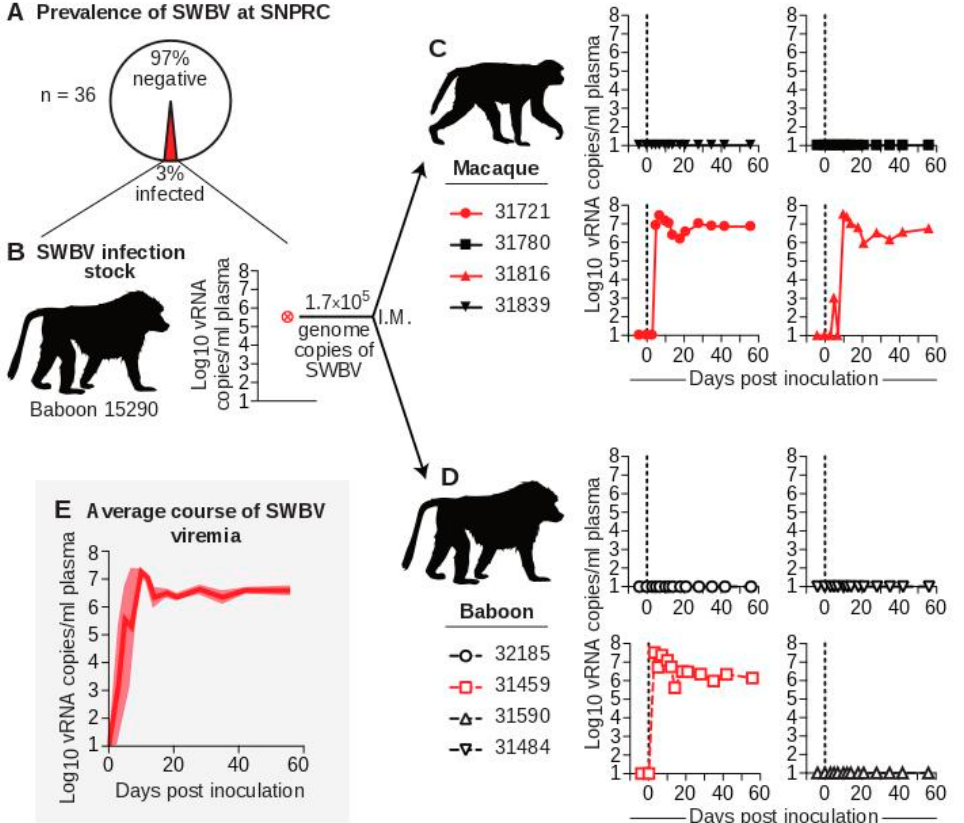
Figure 1. Infection of baboons and macaques with SWBV. ( A ) Thirty-six baboons from the specific-pathogen free (SPF) colony at SNPRC were screened for SWBV infection using qRT-PCR. ( B ) This screening identified one SWBV+ baboon. Serum from this animal was used to inoculate ( C ) macaques (solid symbols with solid lines) and ( D ) baboons (open symbols with dashed lines), resulting in productive infection (red) or no infection (black) for animals from each species. Note: coloring and symbols denoting species, animal ID, and infection-status are used consistently throughout the manuscript. ( E ) The average course of SWBV viremia from all infected animals is in dark red, with the standard error of the mean shown in lighter red.